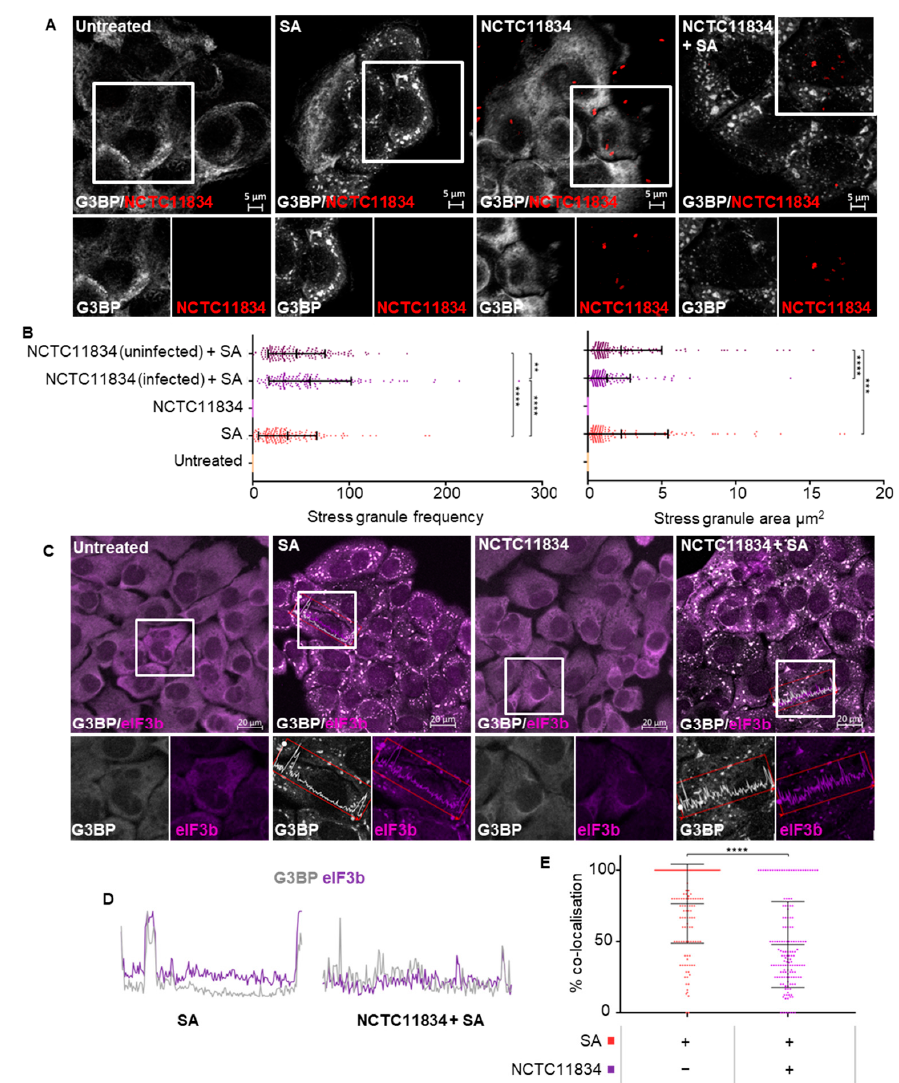
Figure 2. P. gingivalis infection modulates stress granule formation during oxidative stress in H357 cells. ( A ) Stress granule formation as visualized by G3BP1 (white) and P. gingivalis (red) using confocal microscopy and Z-stacks following P. gingivalis (NCTC11834, MOI of 100, t = 2 h) challenge in the presence or absence of sodium arsenite. ( B ) Average area and frequency of stress granules determined in host cells ( n = 3, 50 cells per biological replicate). ( C ) Co-localization of G3BP1 (white) and eIF3B (purple) in stress granules, as assessed by immunofluorescence. ( D ) Representative line segments of color profiles taken from H357 cells challenged with sodium arsenite with or without P. gingivalis (NCTC11834, MOI of 100, t = 2 h) infection, where intensity peaks correspond to stress granules. ( E ) Percentage of colocalization of eIF3b and G3BP1 ( n = 3, 50 cells per biological replicate). **** p ≤ 0.001; ***, p ≤ 0.001; **, p ≤ 0.01 according to Kruskal–Wallis with Conover–Inman